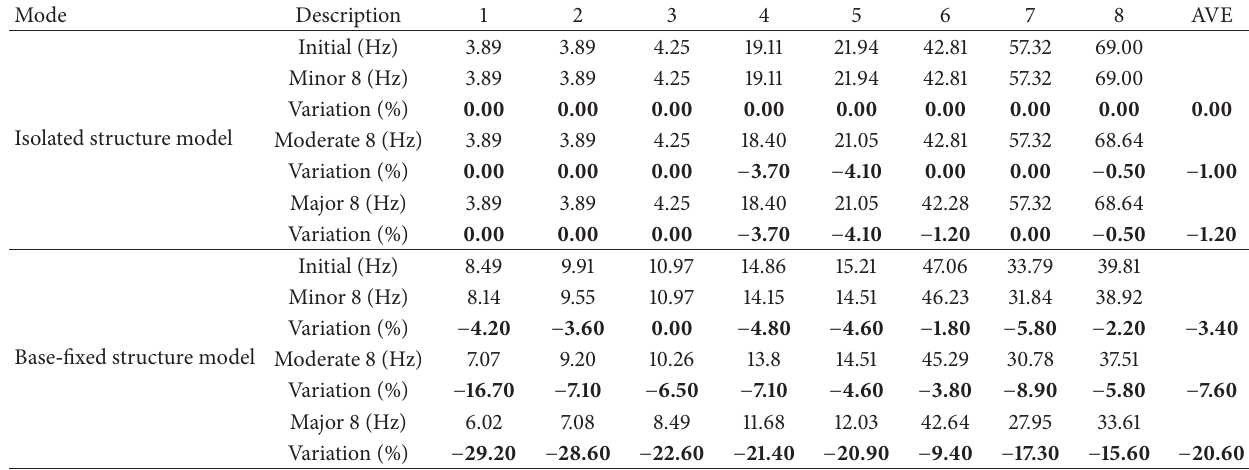
Table 12: Dynamic characteristics test results of isolated structure